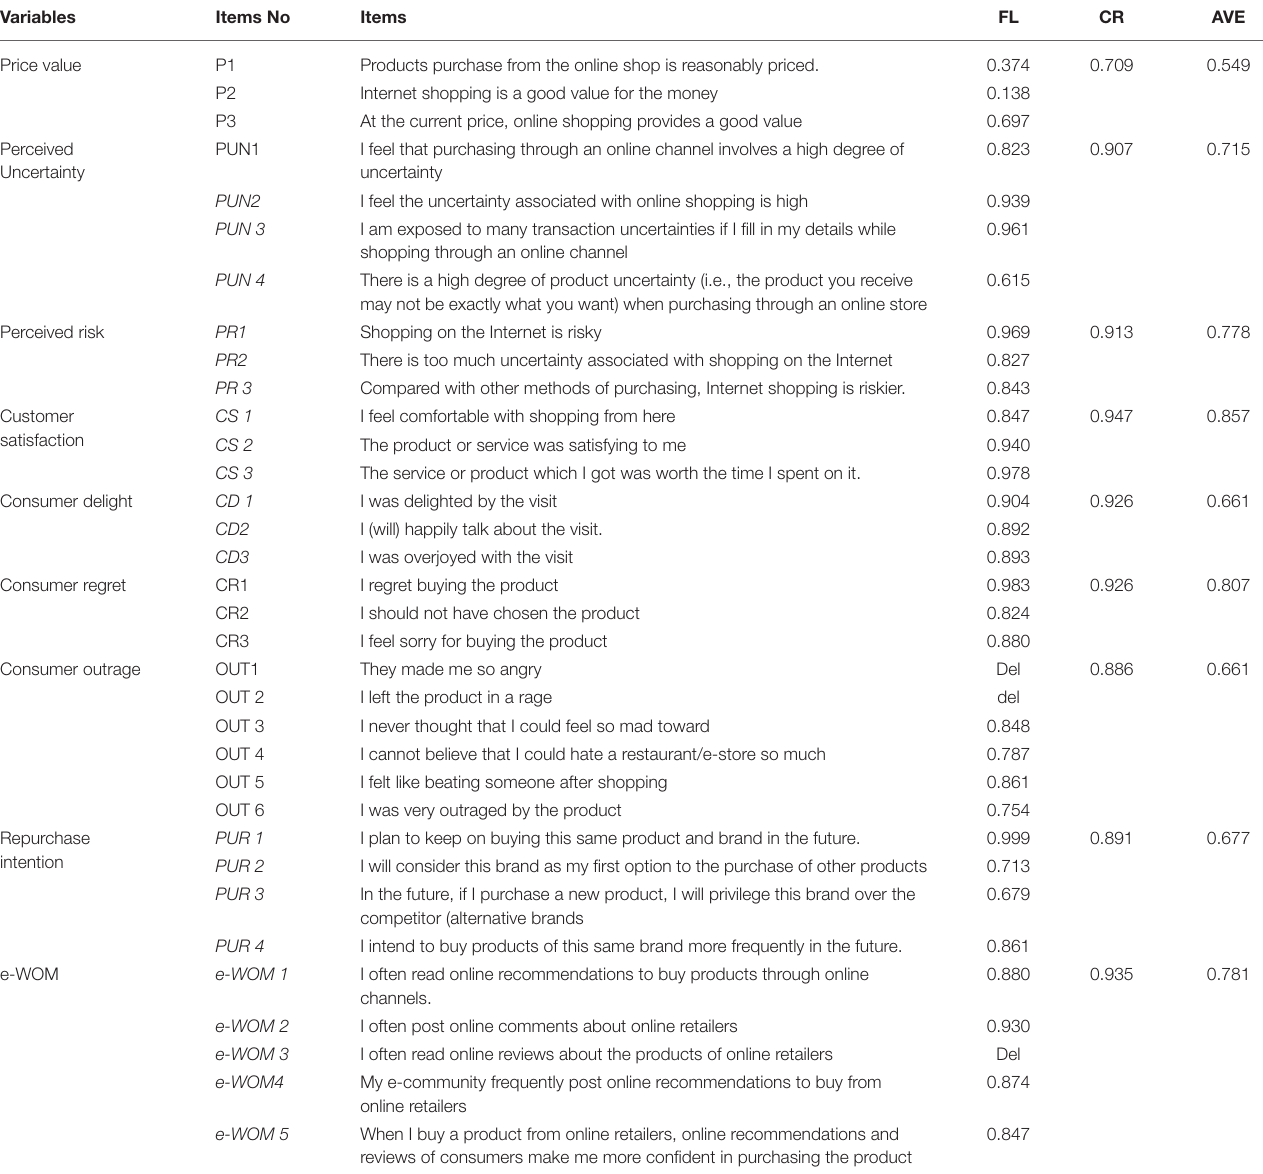
TABLE 2 | Reliability and convergent